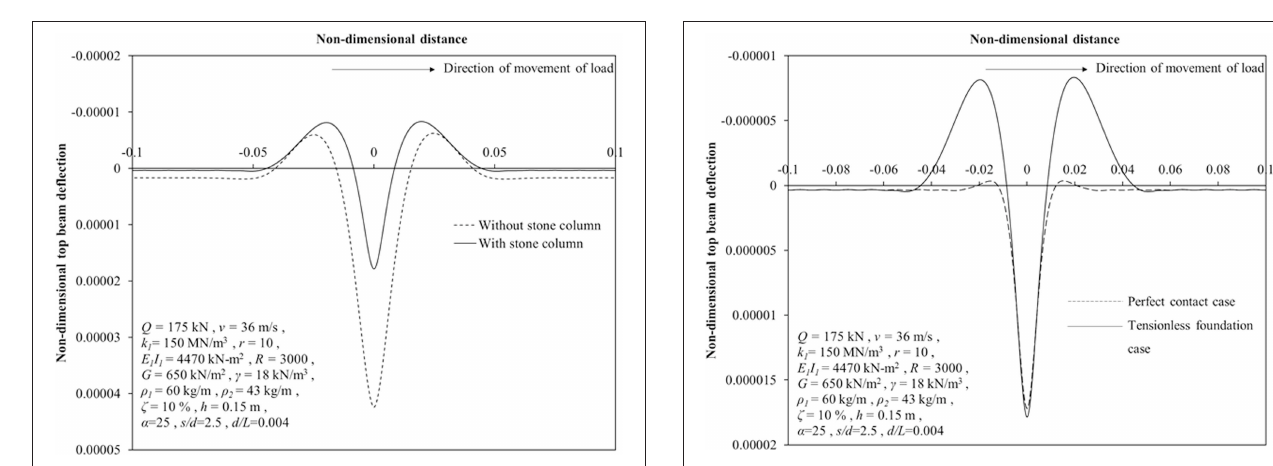
improvement of the earth bed upon inclusion of stone columns.